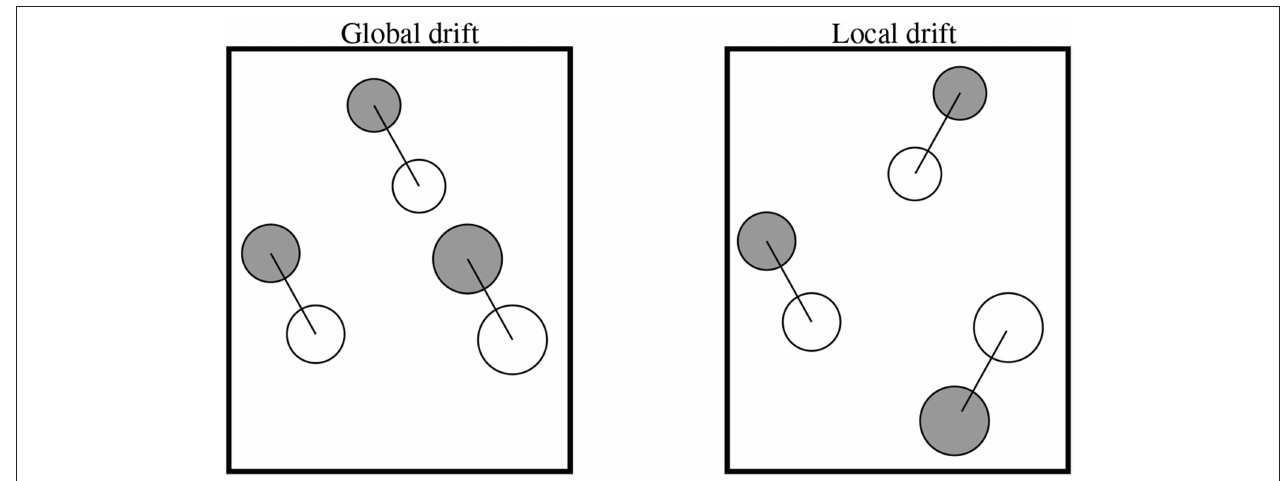
FIGURE 2 | Global and local drift. Here the white bodies are the exact locations of the free-bodies, and the gray bodies are the approximated locations (which have drifted from their exact locations).